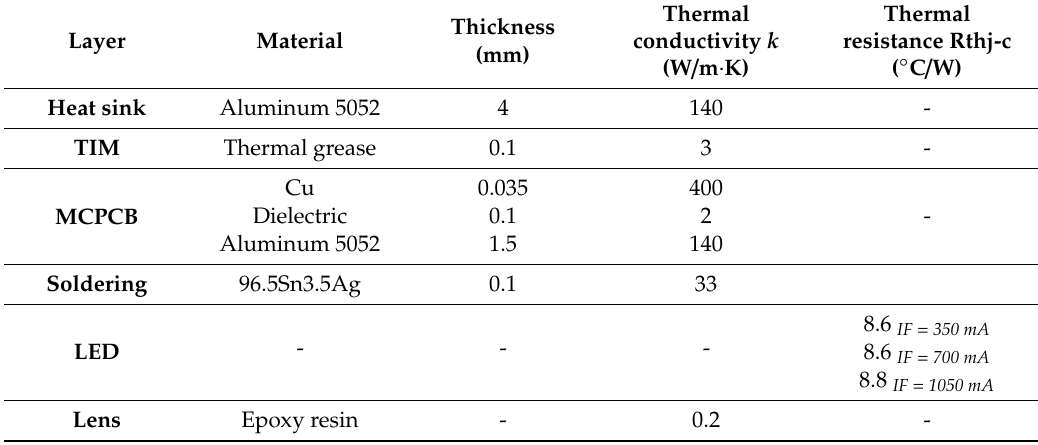
Figure 7. Model of the studied 6 × 2 LED panel with a description of material structure. Table 2. Panel LED — materials and their thermal parameters [48].